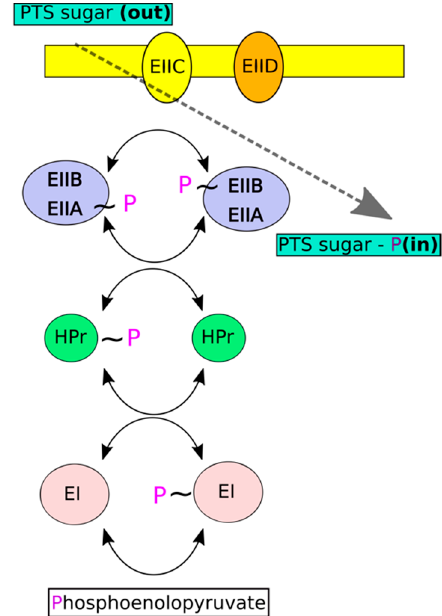
Figure 1. Carbohydrate transport and phosphorylation in phosphotransferase system (PTS) exemplified by mannose-PTS. A membrane embedded sugar specific permease (Enzyme II;